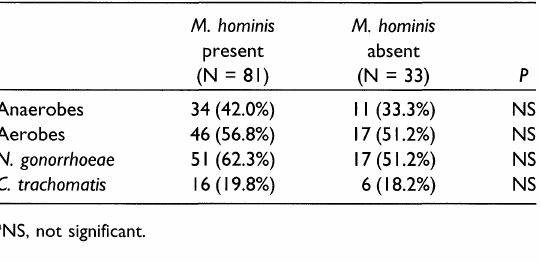
TABLE 3A. Recovery of other microorganisms from endometrial cultures of patients with M. hominis